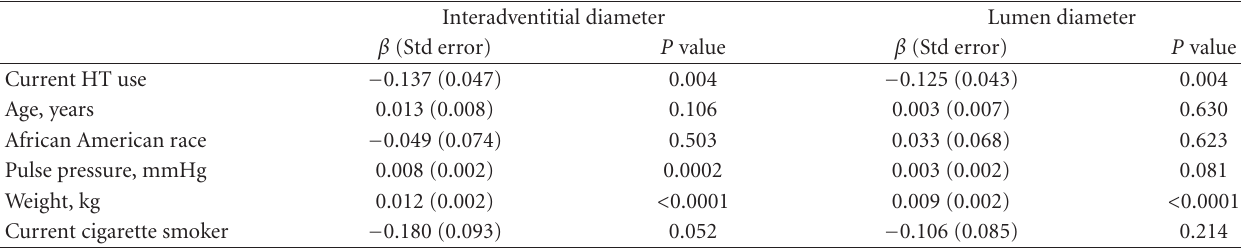
Table 4: Multivariable linear regression of factors associated with common carotid artery